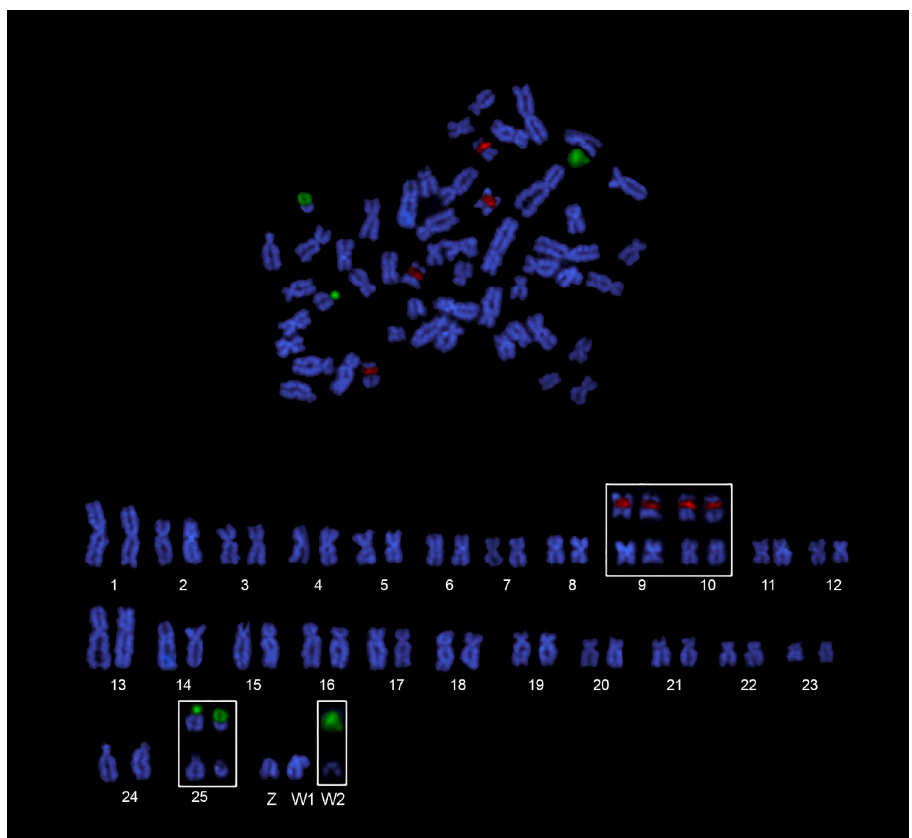
Figure 3. Mitotic chromosomes of A. clementinae . Female metaphase in sequential ( a ) Giemsa and ( b ) DAPI staining; male ( c ) after dual-color FISH experiments with ribosomal 18S (green) and 5S (red) rDNA probes and corresponding DAPI ( d ); female metaphases hybridized with the telomeric (TTAGGG) n probe ( e ) and corresponding DAPI ( f ). Asterisk indicates the W 2 chromosome; arrows indicate 18S rDNA sites and arrowheads 5S rDNA sites.